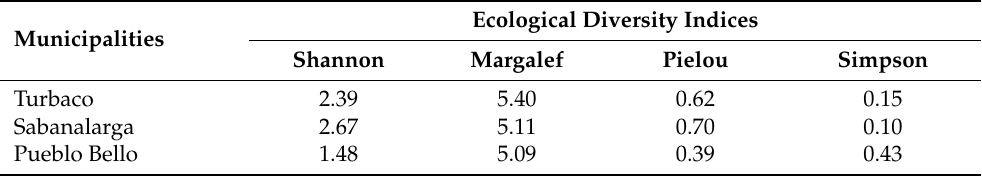
Figure 3. Species similarity dendrograms. ( A ) Jaccard index. ( B ) Bray–Curtis index. Table 1. Ecological indices established in the forest fragments of the municipalities of Turbaco, Sabanalarga and Pueblo Bello .